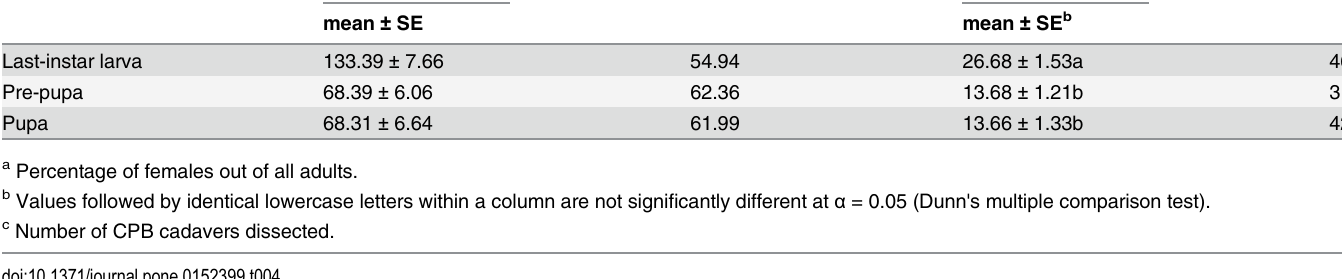
Table 4. Mean number of S . feltiae found in cadavers of L . decemlineata immature stages inoculated with 500 IJs per dish and calculated penetra- tion rates. Treated stage